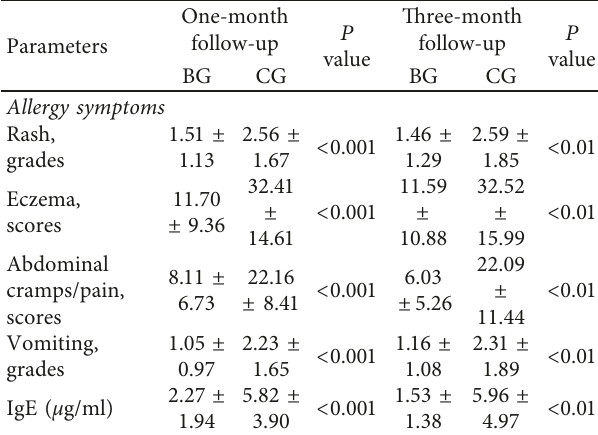
Table 5: The effects of B. lactis on pediatric allergy.